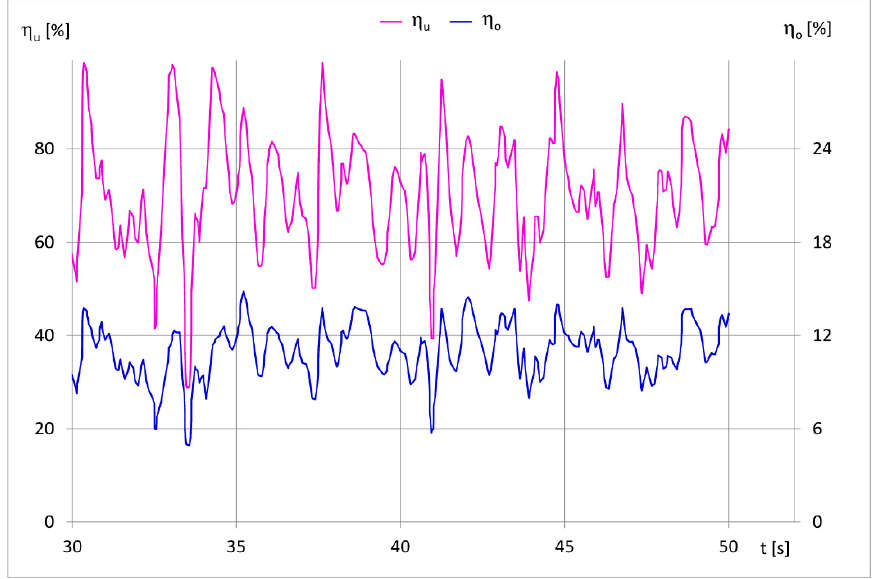
Figure 11. Changes in tractive efficiency η u and total efficiency η o of the tractor unit in the second gear, soil profile—silty loam, and depth setting a nS 1 = 0.13 m.